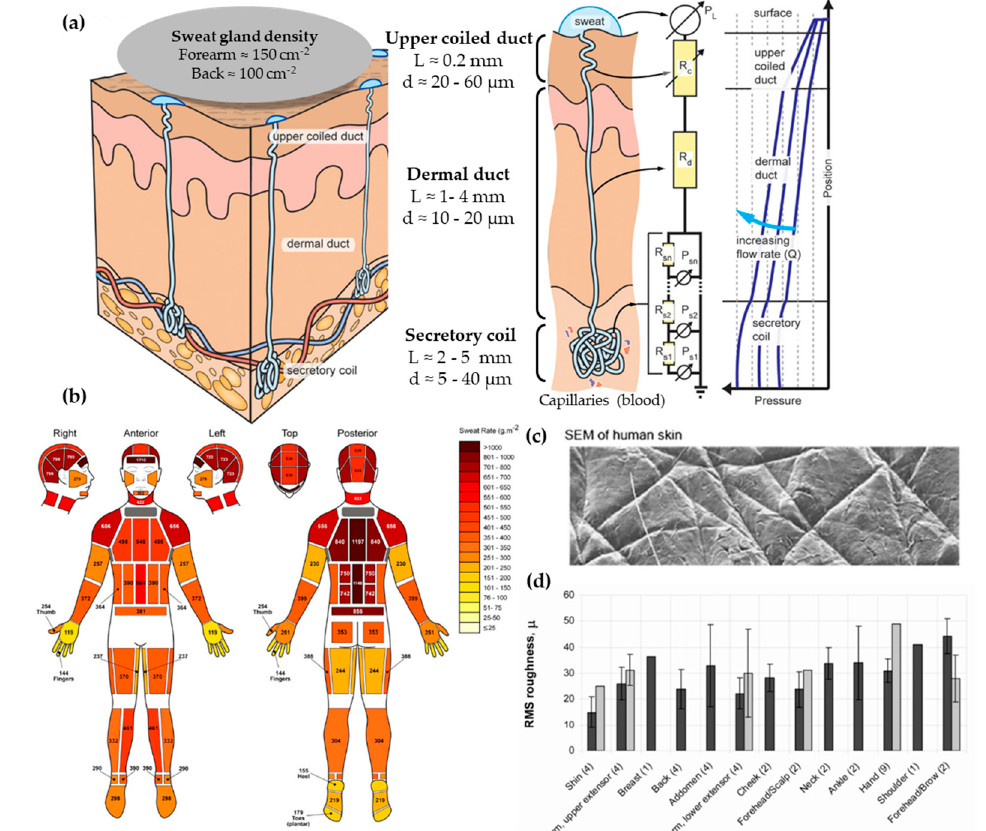
Figure 2. ( a ) Scheme showing human eccrine sweat gland structure and its microfluidic equivalent model. Adapted with permission from [32]. Copyright 2015, AIP. ( b ) Absolute regional median sweat rates of male athletes at a fixed exercise intensity (75% VO 2 ) measured gravimetrically using absorbent pads. Reprinted with permission from [33]. Copyright 2010, Springer Nature. ( c ) SEM photography of human skin. Adapted with permission from [34]. Copyright 2013, Royal Society of Chemistry. ( d ) In vivo skin roughness, RMS values, obtained by a speckle device (black) and fringe projection systems (clear). Reprinted with permission from [35]. Copyright 2010,